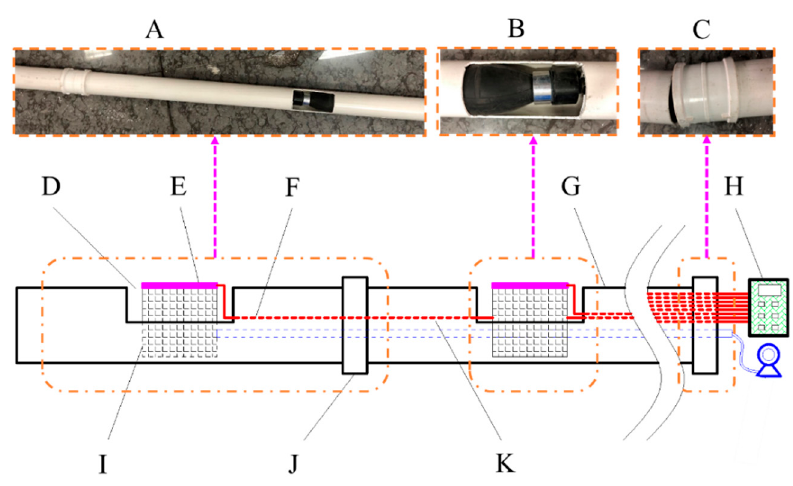
Figure 4. Structural diagram of the EP measuring system for mining. A—PVC push pipe; B—grooves; PVC; C—PVC push pipe joint; D—groove; E—electrode; F—shielding cable; G—PVC push pipe; H—EP host; I—inflatable capsule; J—PVC push pipe joint; K—flexible air conduits.